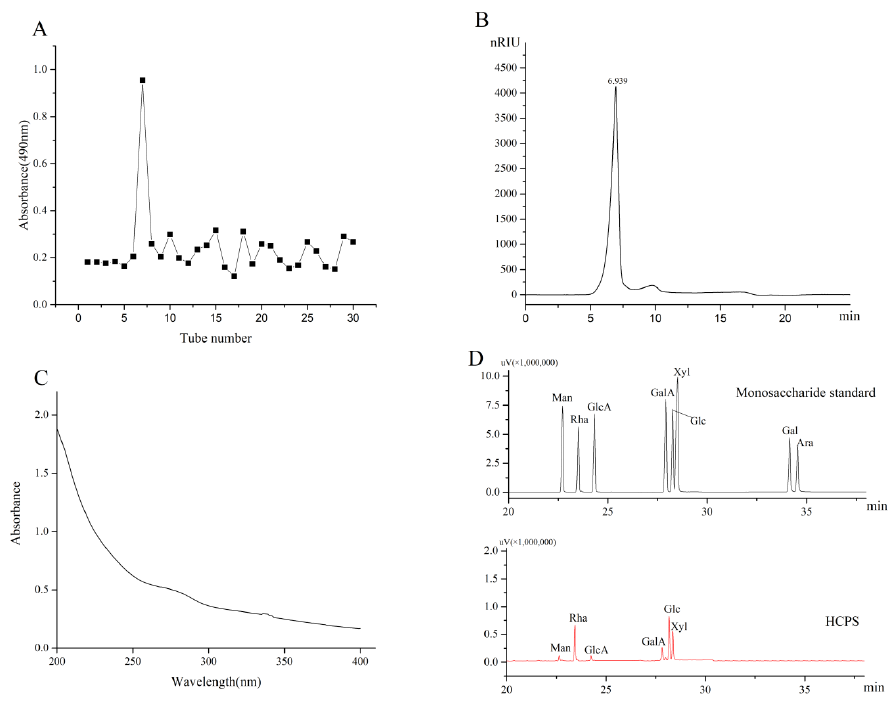
Figure 2. ( A ) Chromatograms of HCPS, ( B ) HPGPC of HCPS, ( C ) UV of HCPS, ( D ) HPLC profiles of acid degraded HCPS and monosaccharide